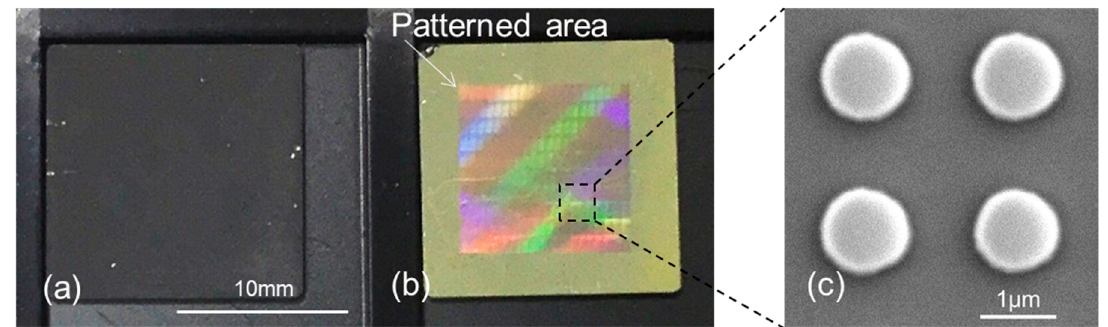
Figure 11. Refractory MDM metasurface and blackbody reference: ( a ) a photograph of the blackbody reference sample, ( b ) the MDM metasurface sample composed of HfN and SiO 2 on a quartz substrate with d = 1.14 µm, P = 2.0 µm, T g = 130 nm, and T d = 200 nm. The patterned area is 10 × 10 mm, and ( c ) SEM image of plasmonic resonators.